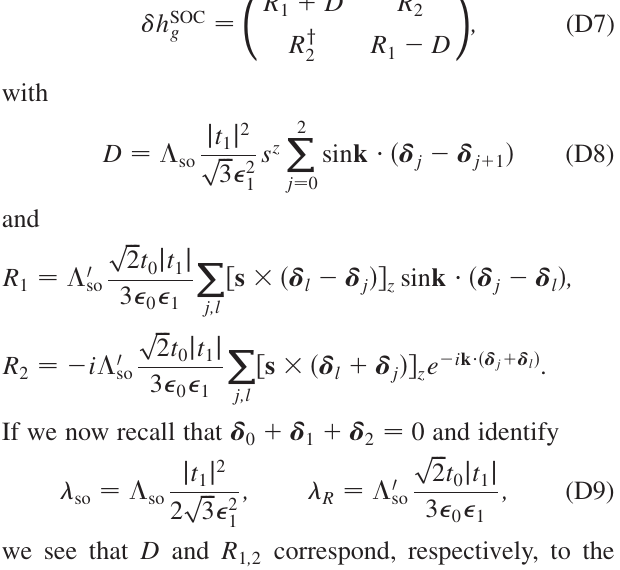
FIG. 7. Hexagonal Rashba effect and substrate-induced disorder. Conductance G as a function of the Fermi energy E including (a) hexagonal Rashba coupling, (b) uncorrelated disorder randomly distributed over the range ½(cid:1) (cid:1) ; (cid:1) (cid:6) , and (c) correlated disorder as defined in Eq. (E1) with (cid:8) ¼ 0 : 07 and d ¼ 5 . In all cases, the system is of size W ¼ 80 and L ¼ 40 with adatom coverage ¼ 0 : 2 and nearest-neighbor hopping strength t ¼ 2 : 7 eV . For panel (a), the intrinsic spin-orbit strength is (cid:2) n i ¼ 0 : 1 t and (c), (cid:2) so